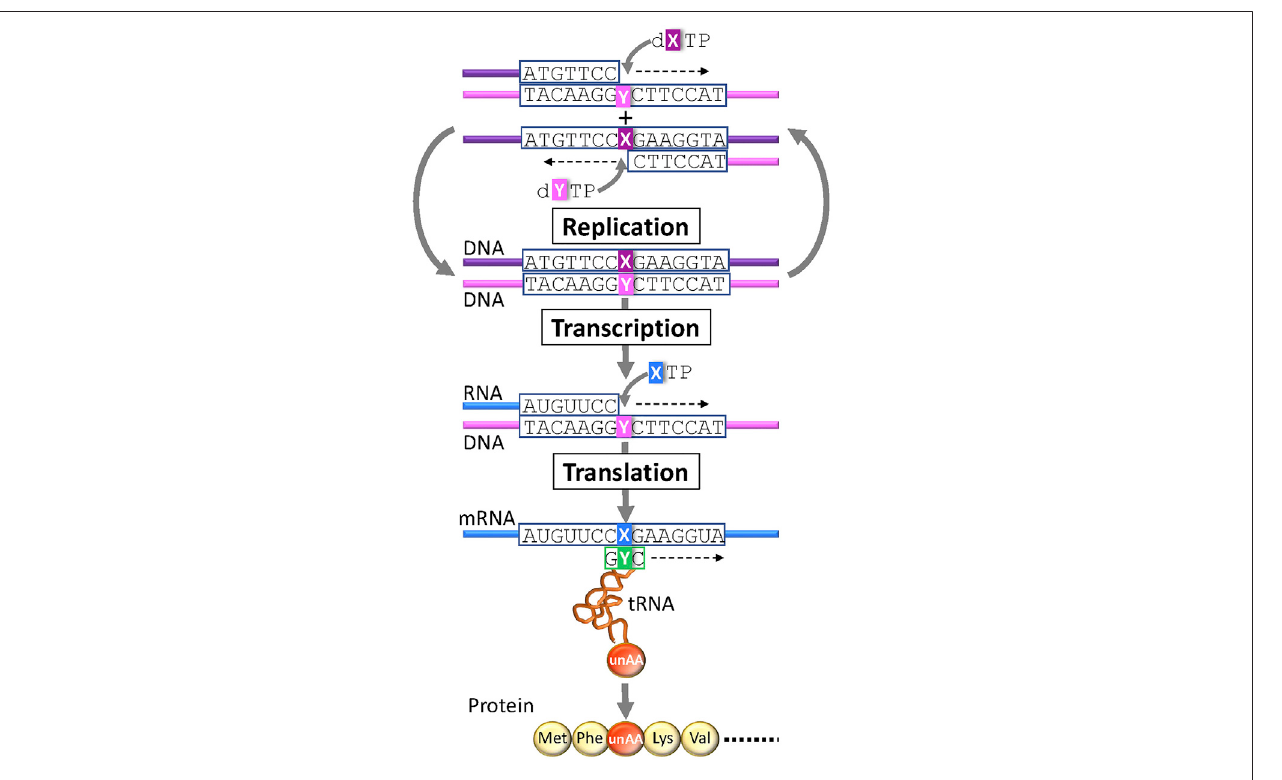
FIGURE3| Geneticalphabetexpansionusinganunnaturalbasepair(UBP)systemforgeneticcodeexpansion. Athirdbasepair(X – Y)thatfunctionsinreplication, transcription,andtranslation,togetherwiththenaturalA – T(U)andG – Cbasepairs,enablesthesite-speci fi cincorporationofunnaturalXandYnucleotidesandunnatural amino acids (unAAs) into nucleic acids and